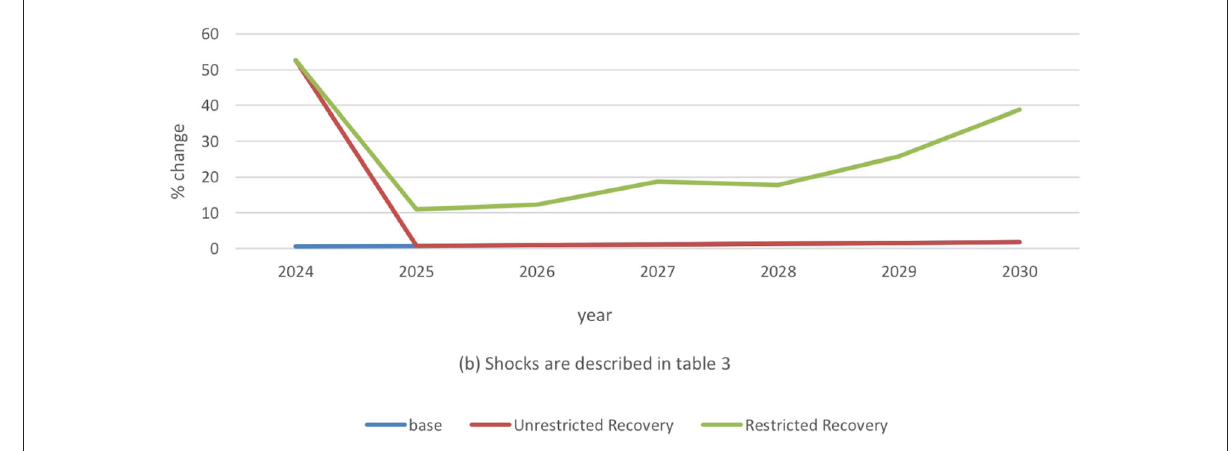
FIGURE6 Traditional pig price changes in restricted recovery scenario. (b) Shocks are described in Table